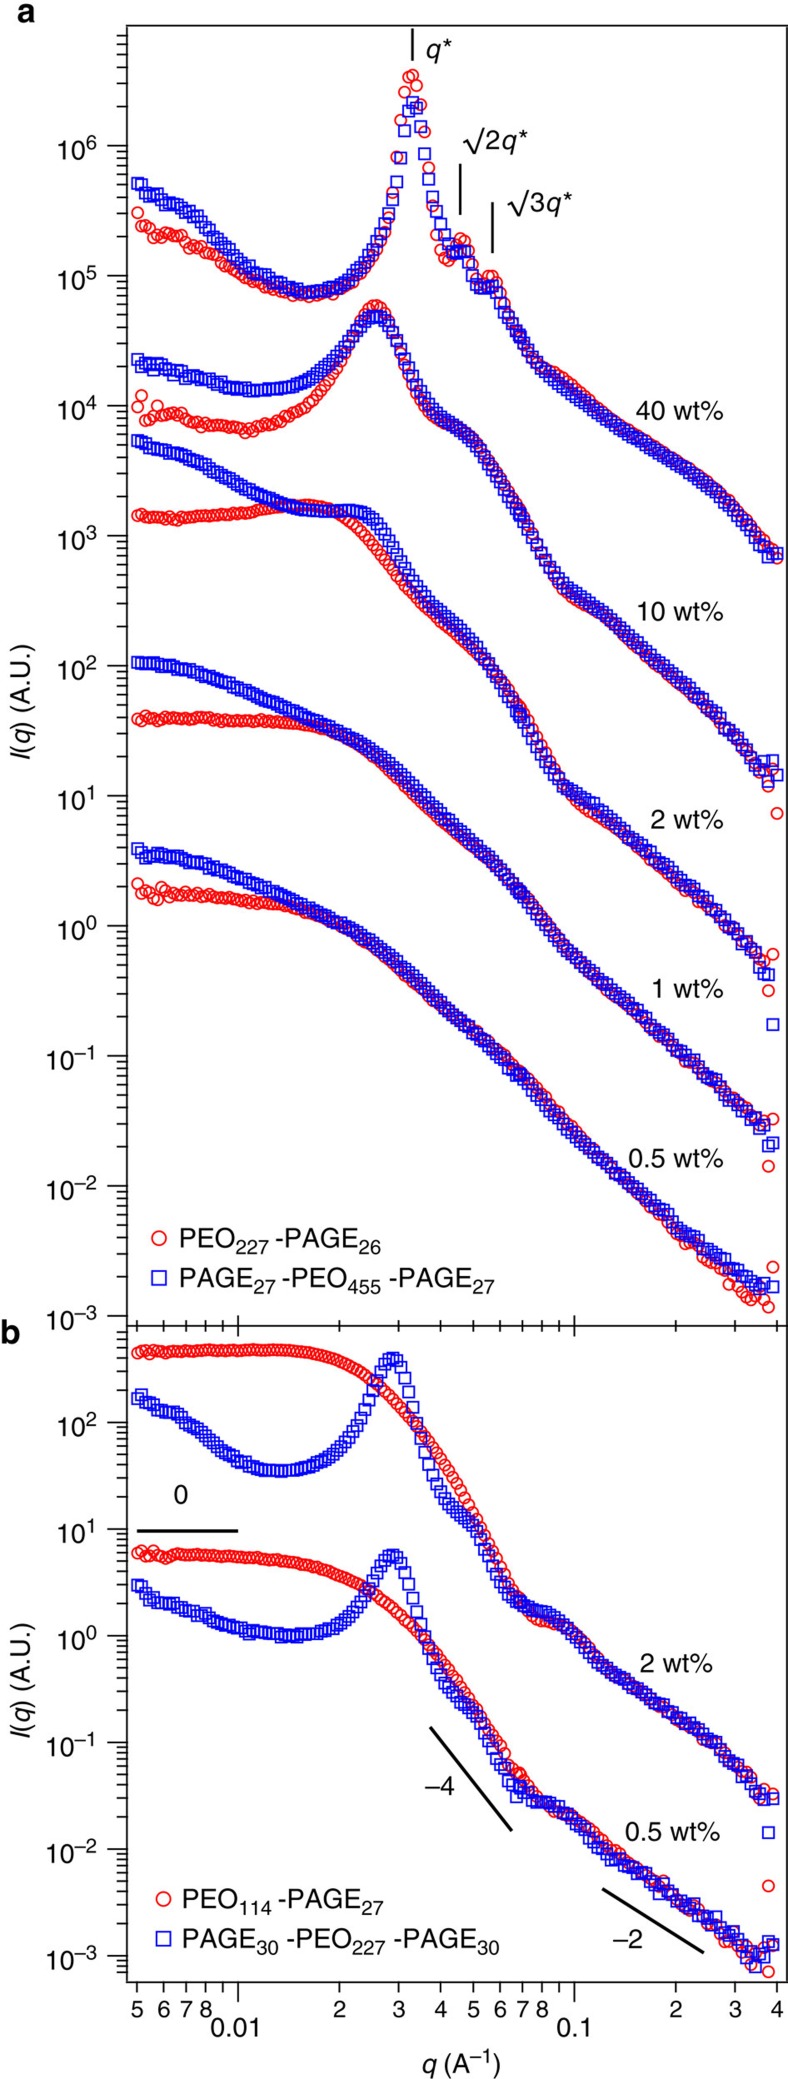
Scattering from di- and triblock copolyelectrolyte self-assemblies.Neutron scattering profiles (I(q) versus wave vector q) from self-assemblies comprising oppositely charged diblock (circles) and triblock (squares) copolyelectrolytes at various polymer concentrations. The polyelectrolytes were oppositely charged functionalized forms of (a) PAGE27-PEO455-PAGE27 and PEO227-PAGE26 and (b) PAGE30-PEO227-PAGE30 and PEO114-PAGE27. In (a) diffraction peaks corresponding to arrangements of complex domains in a BCC lattice are illustrated for the 40% by mass gel. In (b) various power law slopes are indicated by corresponding lines. Error in the data are typically smaller than the symbols and therefore not shown in the figure.